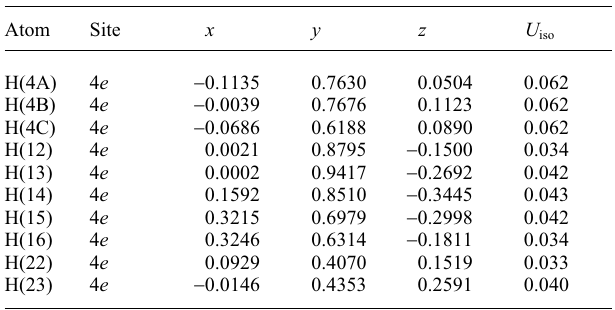
Table 3. Atomic coordinates and displacement parameters (in Å 2 ) .